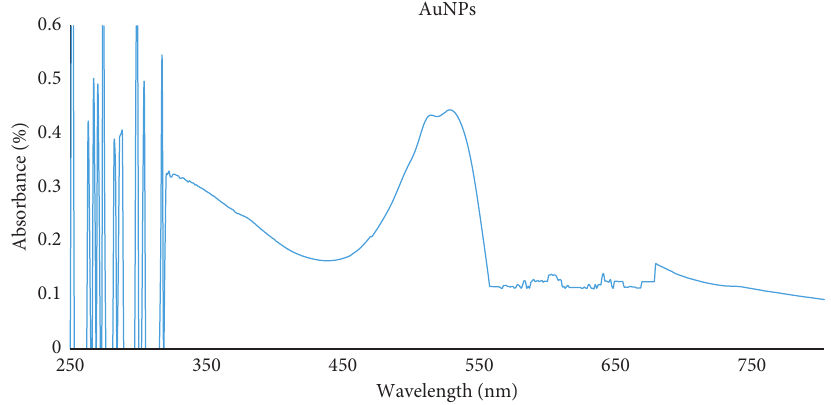
Figure 3: UV-visible spectrum of chemically synthesized gold